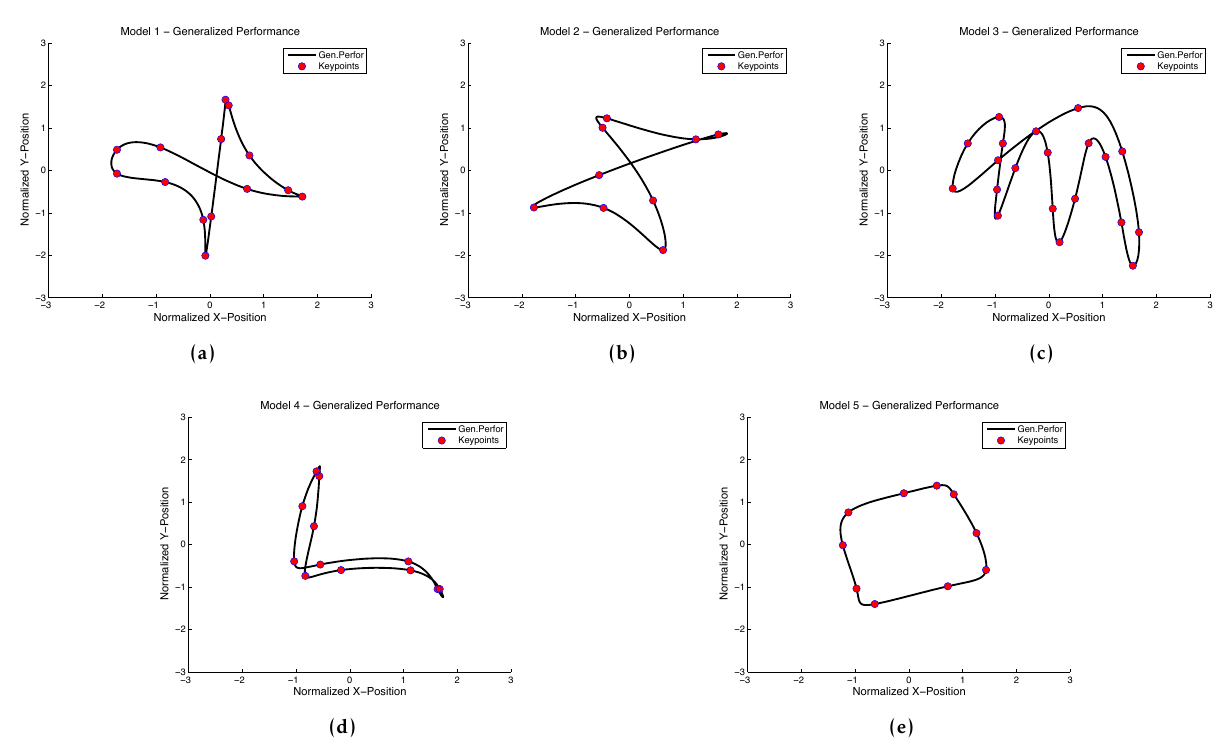
Figure 10. Generalized trajectory and key points of all conducting